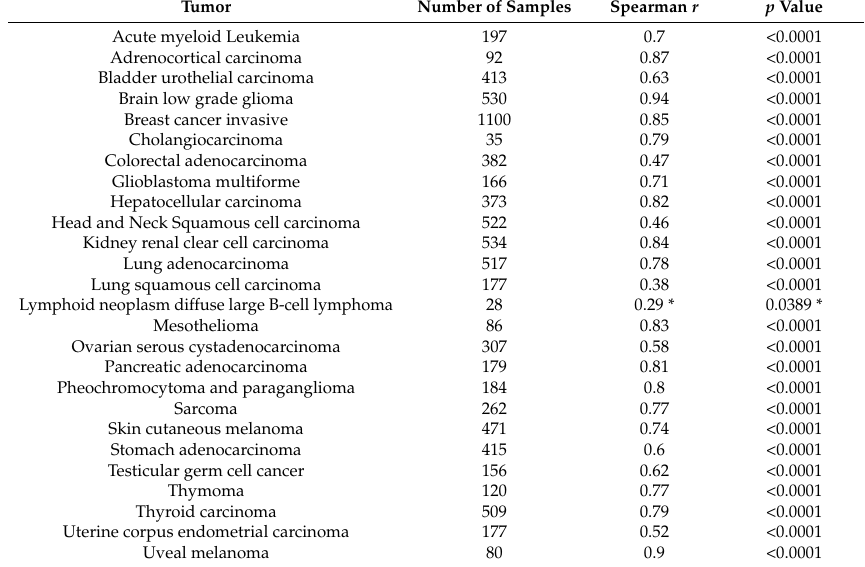
Table 1. Correlation between forkhead box protein M1( FOXM1 ) and ubiquitin conjugating enzyme E2 ( UBE2C ) gene expression in several different human